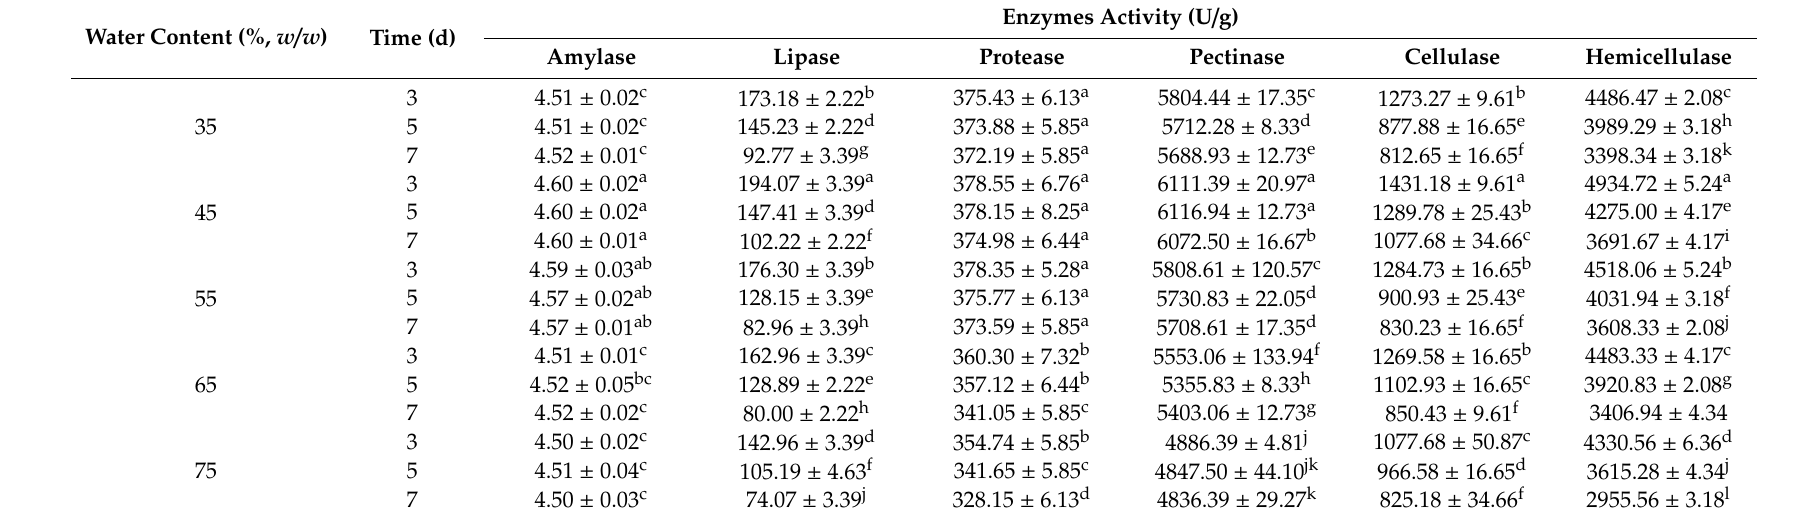
Table 6. E ff ects of the water content on the activities of several enzymes in fermented G. biloba leaves. Water Content (%, w / w